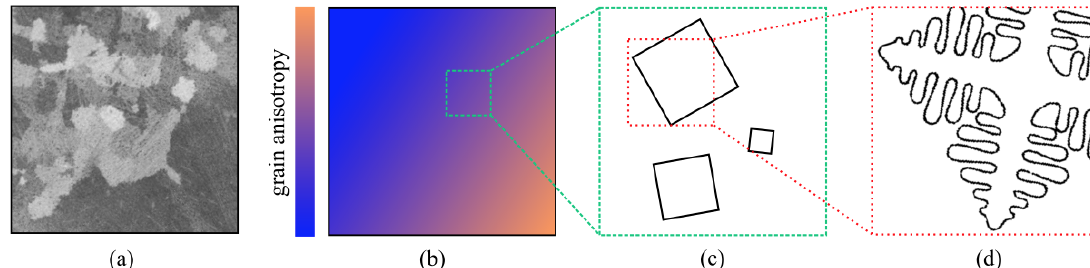
Figure 1. Schematic representation of ( a ) manufactured object microstructure; ( b ) macroscopic scale methods where microstructure is represented by variables such as grain anisotropy, etc. at a relatively low computational cost; ( c ) mesoscopic scale methods, representing a compromise solution at a moderate numerical cost and delivering microstructure at a lower resolution by tracking solely the grain envelopes; and ( d ) microscopic scale methods, where the complete dendritic grain microstructure is modelled at a high numerical